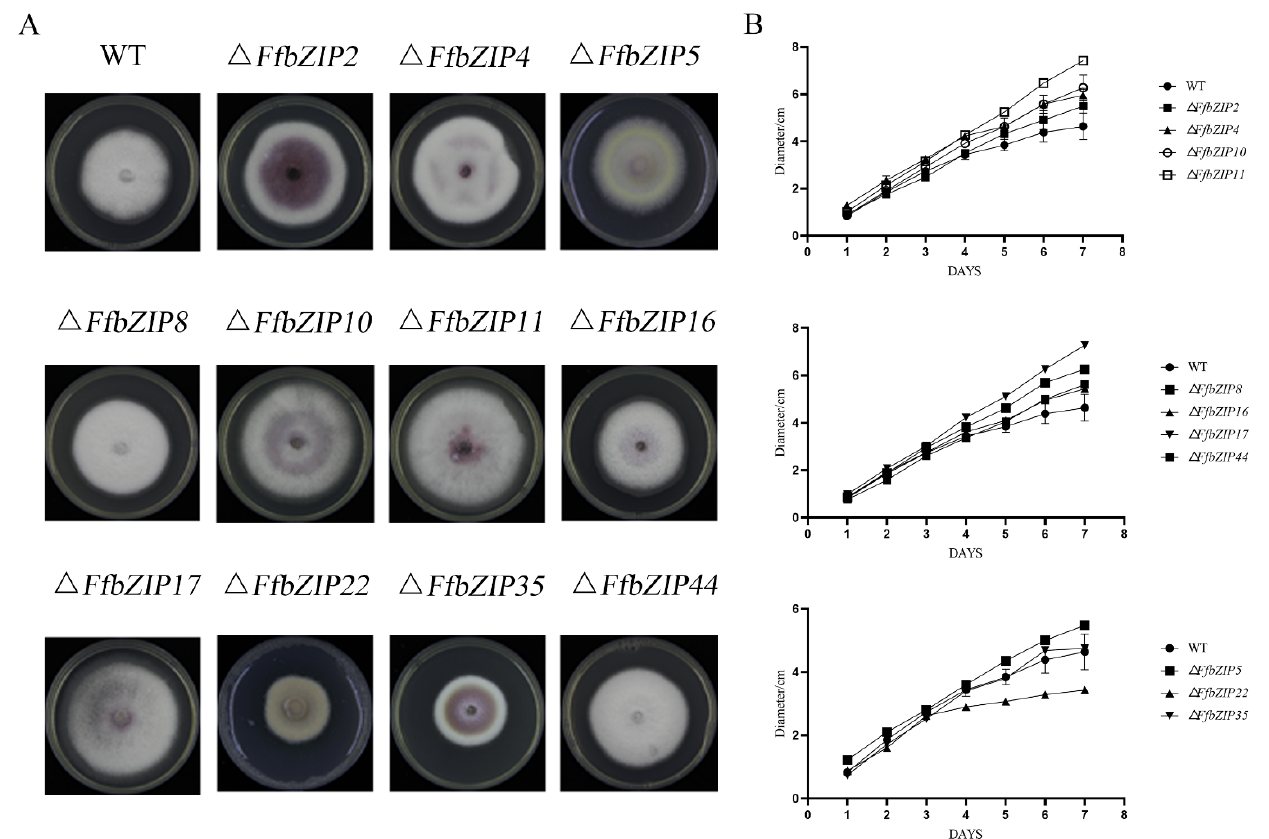
Figure 4. Fungi morphology observation. ( A ) Colony morphology of FfbZIP knockout mutant strain. ( B ) Growth rate of FfbZIP knockout mutants versus wild type. Error bars represent means ± SEs. Some error bars were not plotted because the error bar would be shorter than the size of the symbol.